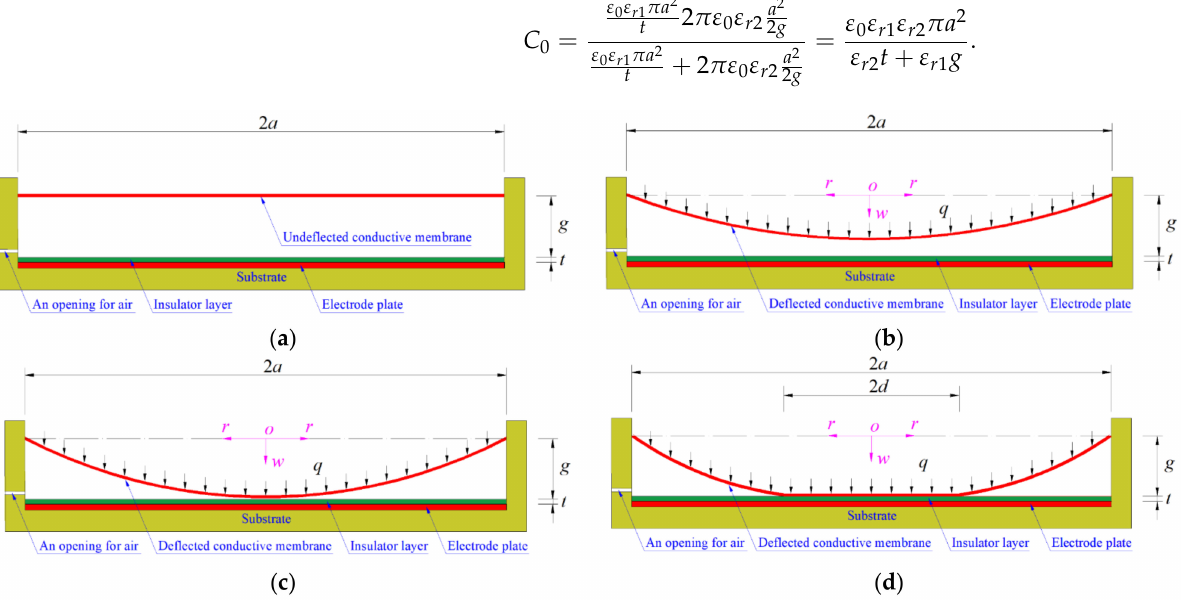
Figure 1. Sketch of a capacitive pressure sensor from non-touch mode of operation to touch mode of operation: ( a ) initial state; ( b ) non-touch mode of operation; ( c ) critical state from non-touch mode of operation to touch mode of operation; ( d ) touch mode of